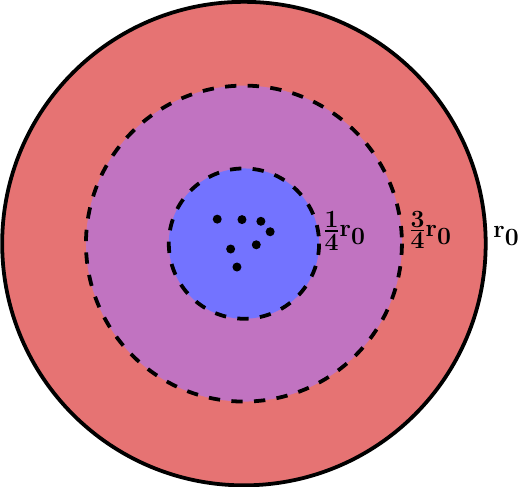
Figure 2 . The fundamental region of the action of (cid:27) on P 1 pieces D (cid:0) and D + . We are working in a limit of moduli space of X where all the singular (cid:12)bres of the K3 (cid:12)bration are con(cid:12)ned to a small region r < 1 that the monodromy acting on the K3 (cid:12)bre over the circle with r = r 0 is trivial.